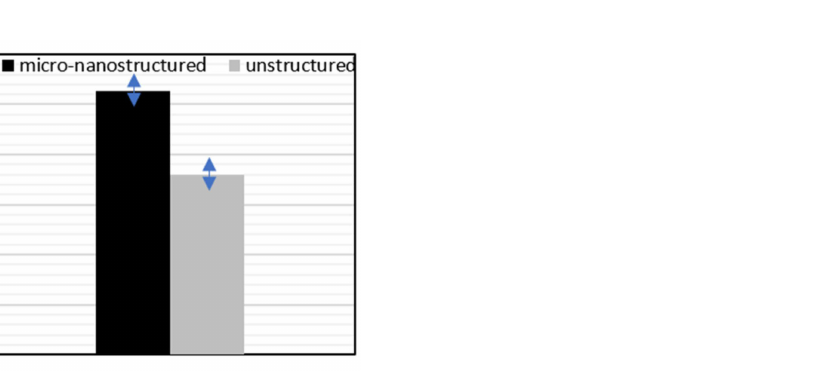
Figure 7. Disappearance rate of FA per µ g of Ti obtained for micro-nanostructured and unstructured TiO 2